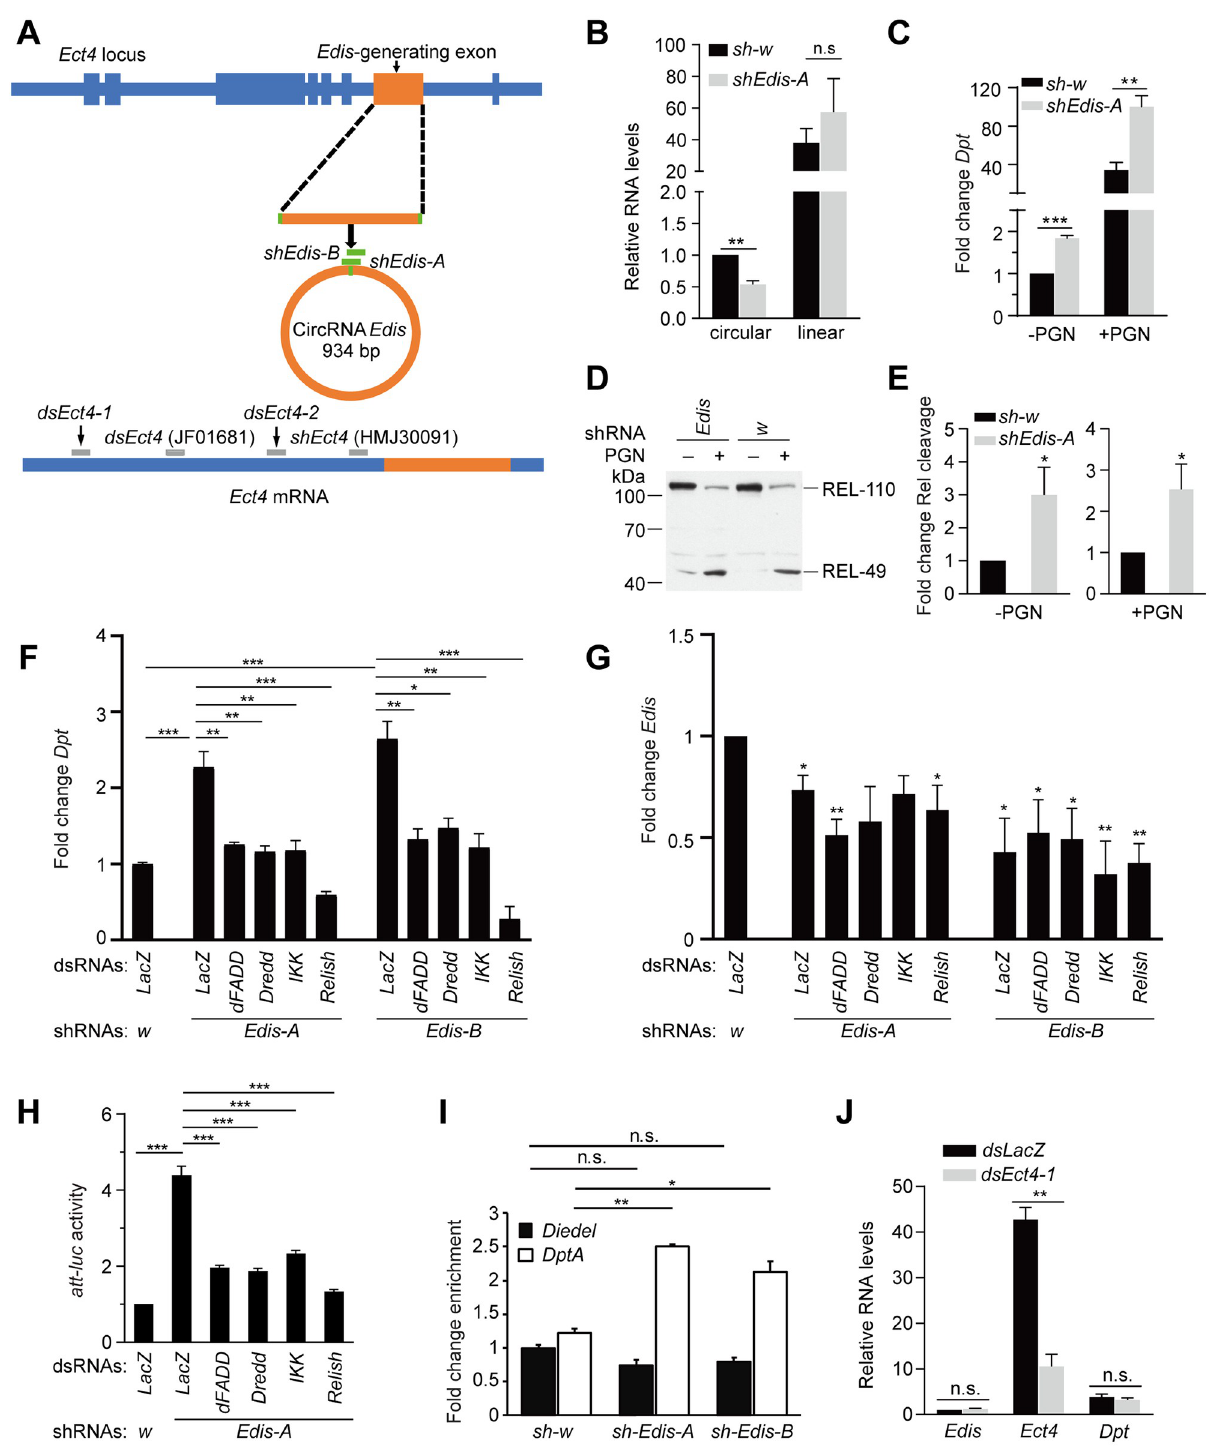
Fig 1. Edis depletion impacts innate immunity signaling. ( A ) A diagram depicting the linear Ect4 mRNA and circular RNA Edis derived from the Ect4 locus as well as the mapping of various dsRNA/shRNA reagents targeting Ect4 (gray bars) or Edis (green bars). Thick and thin bars, respectively, represent exons and introns. ( B-C ) S2 cells stably transfected with an shRNA construct targeting the back-spliced exon junction of Edis ( shEdis-A ) or a control (Ctrl) shRNA against white ( w ) were treated with 20-hydroxyecdysone ( 20-HE ) and subsequently with (+) or without PGN (-). Levels of linear Ect4 and circular Edis transcripts ( B ) or Diptericin ( Dpt ) mRNA ( C ) were measured by RT-qPCR and normalized to RpL32 (student t test, n = 3, �